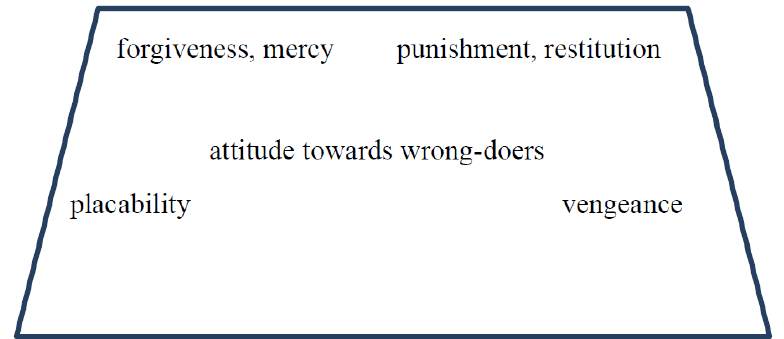
Figure 2. Forgiveness and Restitution Virtuous Trapezium (See Selling 2016, p. 234).